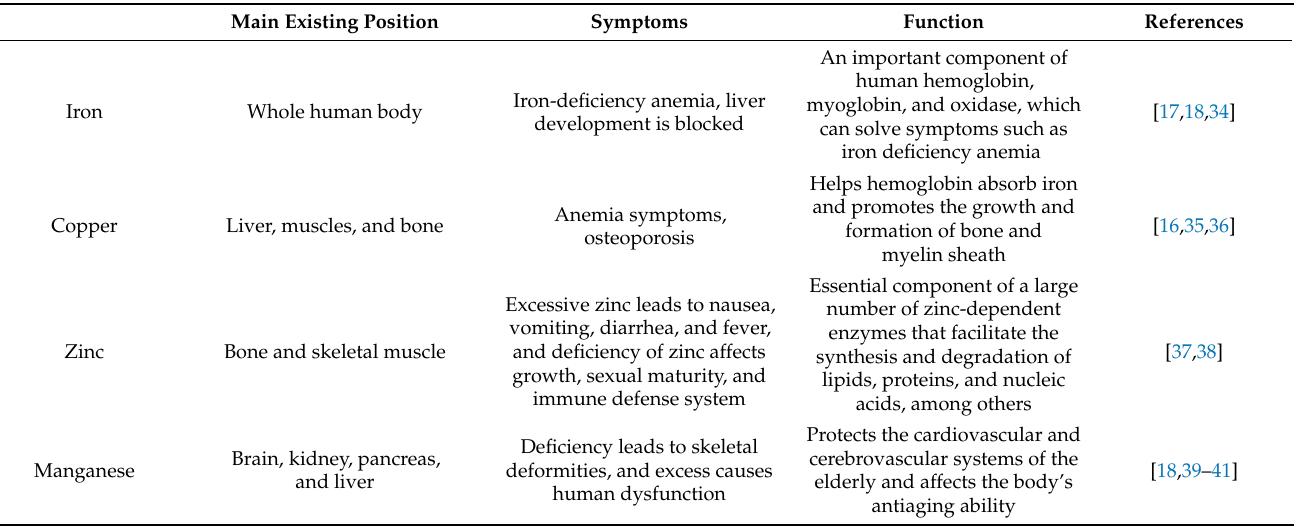
Table 1. Functional characteristics of essential trace elements for the human